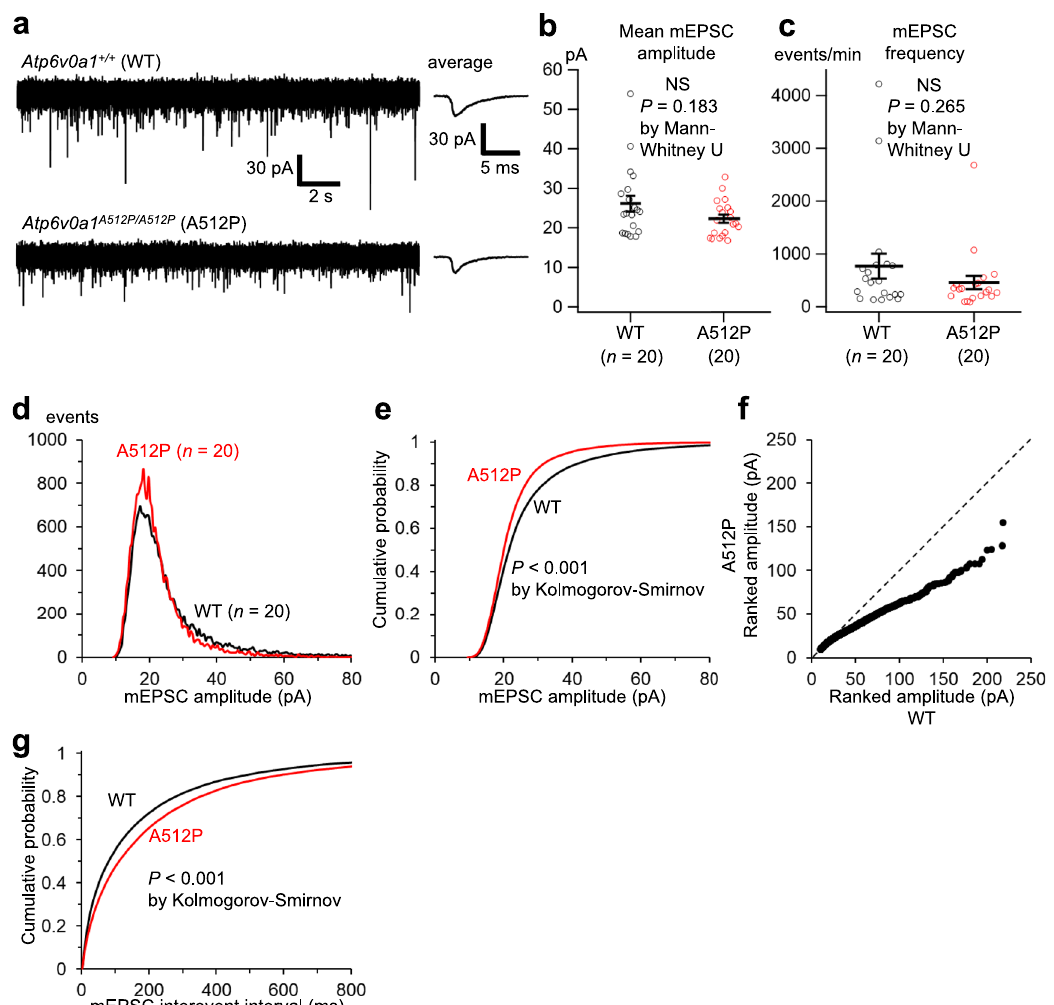
Fig. 9 Comparison of mEPSCs in Atp6v0a1 + / + (WT) and Atp6v0a1 A512P/A512P (A512P) neurons. a Representative traces of mEPSCs in WT and A512P neurons. The average of individual mEPSCs in each trace is shown on the right. b , c The mean amplitude ( b ) and frequency ( c ) of 1000 consecutive mEPSCs in each neuron are plotted and compared. The differences in both parameters between WT and A512P did not reach statistical signi fi cance (NS, P = 0.183 by Mann – Whitney U test in b and P = 0.265 by Mann – Whitney U test in c ). Horizontal line, mean; error bars, s.e.m. d , e Histograms ( d ) and cumulative distributions ( e ) of the amplitudes of a total of 20,000 mEPSCs in the WT and A512P neuron groups. The bin widths were 0.5 pA in d and 0.1 pA in e . The plots clearly indicate an increased proportion of small mEPSCs (~20 pA) and a decreased proportion of large mEPSCs (30 – 50 pA) in the A512P group, compared with the WT group. The distributions were signi fi cantly different between WT and A512P ( P < 0.001 by Kolmogorov – Smirnov test). f Ranked mEPSC amplitudes in ascending order in the A512P group were plotted against those in the WT group. The dashed line indicates the level when the amplitude distributions are the same. The slope of the plots was clearly lower than the dashed line as a result of the smaller proportion of large mEPSCs in the A512P group. g Cumulative distributions of interevent intervals of mEPSCs, indicating a signi fi cantly larger proportion of long intervals in the A512P group ( P < 0.001 by Kolmogorov – Smirnov test). Source data are provided as a Source data fi Lysosomal pH value measurement . Parental HEK293FT cell line and stable Immunocytochemistry and LysoTracker staining . N2A and HEK293FT cells HEK293FT cell lines expressing ATP6V0A1-3×HA were incubated for 1h at 37 °C were cultured on round coverslips in a 24-well dish. For immunostaining of with 0.5 mg/mL of a ratiometric pH indicator dye, LysoSensor TM Yellow/Blue HEK293FT cells, cells were fi xed in 10% formalin/phosphate buffered saline (PBS) dextran (L22460, Thermo Fisher Scienti fi c) in a 96-well plate. Fluorescence was solution for 10 min at room temperature (RT) and permeabilized with 0.2% Triton measured with the Synergy H1 Hybrid Multi-Mode Reader (BioTek), using exci- X − 100/PBS for 10min at RT. For co-staining of N2A cells with LysoTracker, cells tation at 355 nm and emission detection at 440 and 535 nm. To obtain a pH were fi rst incubated with LysoTracker Red DND-99 (1/10,000, L7528, Thermo calibration curve, cells were resuspended in the MES-buffered calibration solution Fisher Scienti fi c) for 1 h at 37 °C before fi xation, and permeabilization step was (115mM KCl, 5mM NaCl, 1.2mM MgSO4 and 25 mM MES (2-morpholi- omitted. After washing twice with PBS and blocking with 3% bovine serum noethanesulfonic acid, monohydrate, 145224-94-8, DOJINDO) with pH ranging albumin (BSA)/PBT (PBS + 0.1% Tween-20) for 1h at RT, cells were incubated from 3.7 to 7.6) containing ionophores of 10 mM Monensin (CAS:22373-78-0, overnight at 4°C with rat anti-HA (1/200, 11867423001, Roche) for both Cayman) and 10 mM Nigericin (149-07261, Wako). The calibration data set of HEK293FT and N2A cells, and also rabbit anti-ATP6V1A (1/500, ab137574, fl uorescence ratios (440nm/535 nm) were fi tted to a linear regression line using the Abcam) and mouse anti-Lamp2 (1/200, ABL-93, DSHB) for HEK293FT cells as software GraphPad Prism 7. The formula of the line was Y = 6.383 X − 3.635. For primary antibodies. After washing three times with PBS, cells were incubated for pH measurements, cells were incubated in the MES-buffered solution at pH 7.7 1 h at RT with Alexa Fluor 488 donkey anti-rat IgG (for both HEK293FT and N2A without ionophores. Six independent pH measurements were made for each of the cells), and with Alexa Fluor 546 donkey anti-rabbit IgG and Alexa Fluor 647 goat cell lines expressing wild-type and three different mutants of ATP6V0A1 anti-mouse IgG (for HEK293FT cells, 1/500 dilution, Thermo Fisher Scienti fi c) as (ATP6V0A1 WT -3×HA, ATP6V0A1 A512P -3×HA, ATP6V0A1 N534D -3×HA, and secondary antibodies. After washing three times with PBS, cells were stained with the nuclear marker DAPI and mounted with VECTASHIELD Hard Set Mounting ATP6V0A1 R741Q -3×HA).